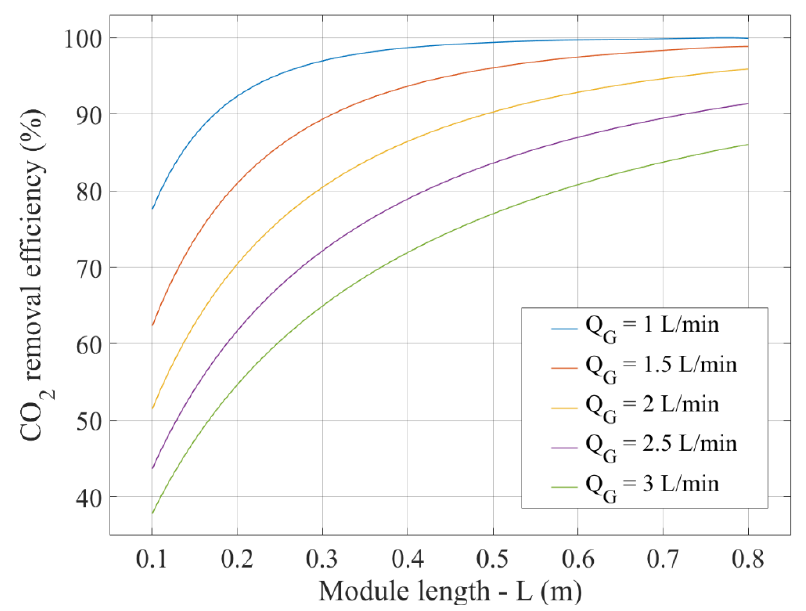
Figure 11. Effect of the module length on the CO 2 removal efficiency at different gas flow rates, Q L = 25L · h − 1